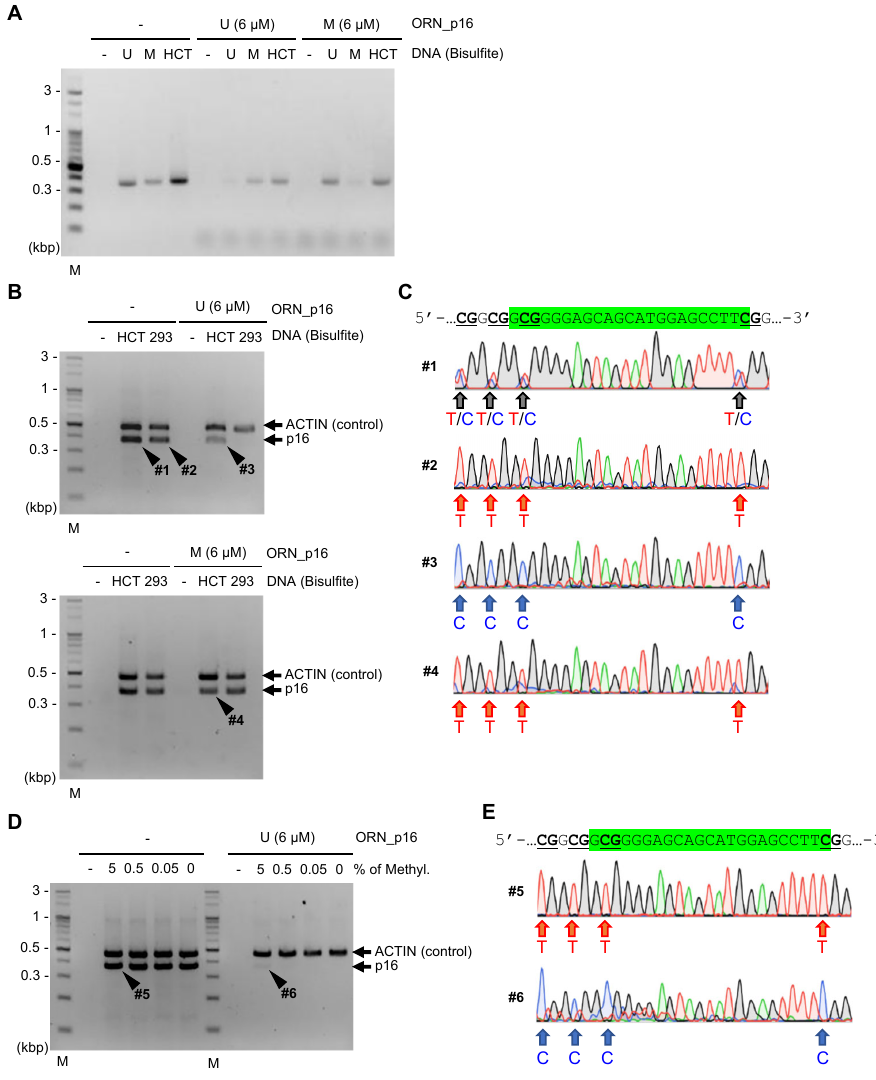
Figure 7. ORNi-PCR with bisulfite-treated DNA. ( A ) Results of ORNi-PCR with bisulfite-treated DNA. EpiTect PCR Control DNA Set (U and M) and bisulfite-treated HCT116 gDNA were used as templates. ( B ) Results of ORNi-PCR combined with internal control PCR. The human ACTB gene was amplified as an internal control. ( C ) Results of DNA sequencing analysis. PCR (#1, #2) or ORNi-PCR (#3, #4) amplicons, shown in ( B ), were subjected to DNA sequencing analysis. Sequencing signals around the ORN target site (green) are shown. CpG sites are underlined. ( D ) Sensitivity of ORNi-PCR with bisulfite-treated gDNA. 293T gDNA mixed with HCT116 gDNA (0–5% of CpG-methylated CDKN2A (p16) in total CDKN2A (p16) ) was subjected to bisulfite treatment. ( E ) Results of DNA sequencing analysis. PCR (#5) or ORNi-PCR (#6) amplicons shown in ( D ) were subjected to DNA sequencing analysis. Sequencing signals around the ORN target site (green) are shown. CpG sites are